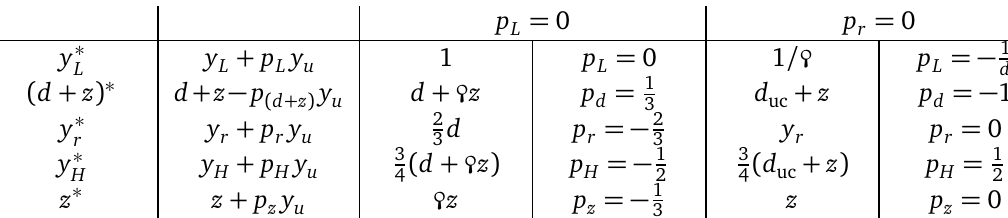
corresponds to leaving the scaling power of the inverse L leaves the scaling power of the character- r = 0 p L